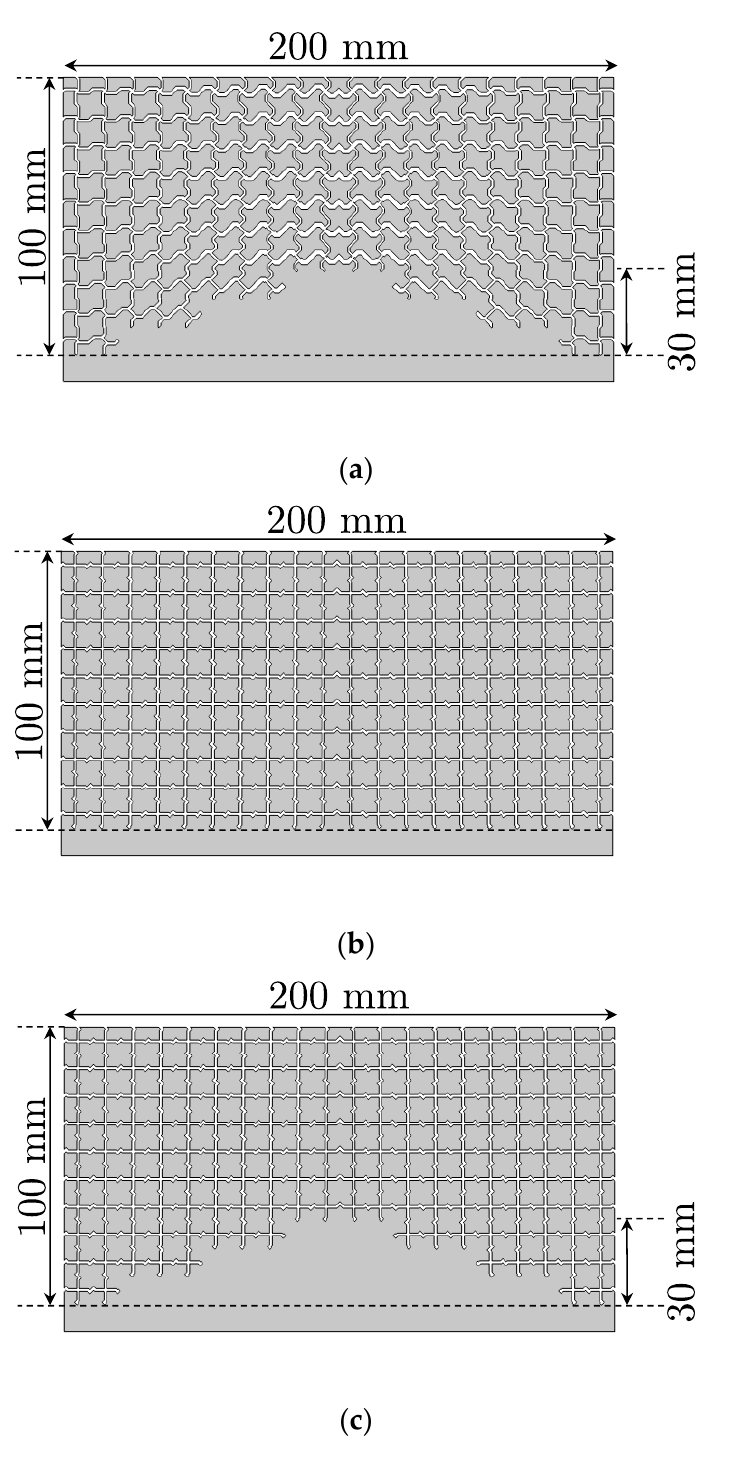
Figure 10. Designed acoustic carpet cloak and the additional designed structures for comparison. ( a ) Carpet cloak; ( b ) flat surface; ( c ) bump. These sizes are 2 p × h = 200 mm × 100 mm (2 p × h ) and those are discretized by using unit cells of Figure 3 (carpet cloak case) and Figure 4 (flat surface and bump cases) whose sizes are ∆ d × ∆ d = ∆ d b × ∆ d b = 10 mm × 10 mm. The structural parameters of Figure 8 are adopted to the unit cells of the carpet cloak, and those for the flat surface and the bump are w b = 1.0 mm and l b = 11 mm.